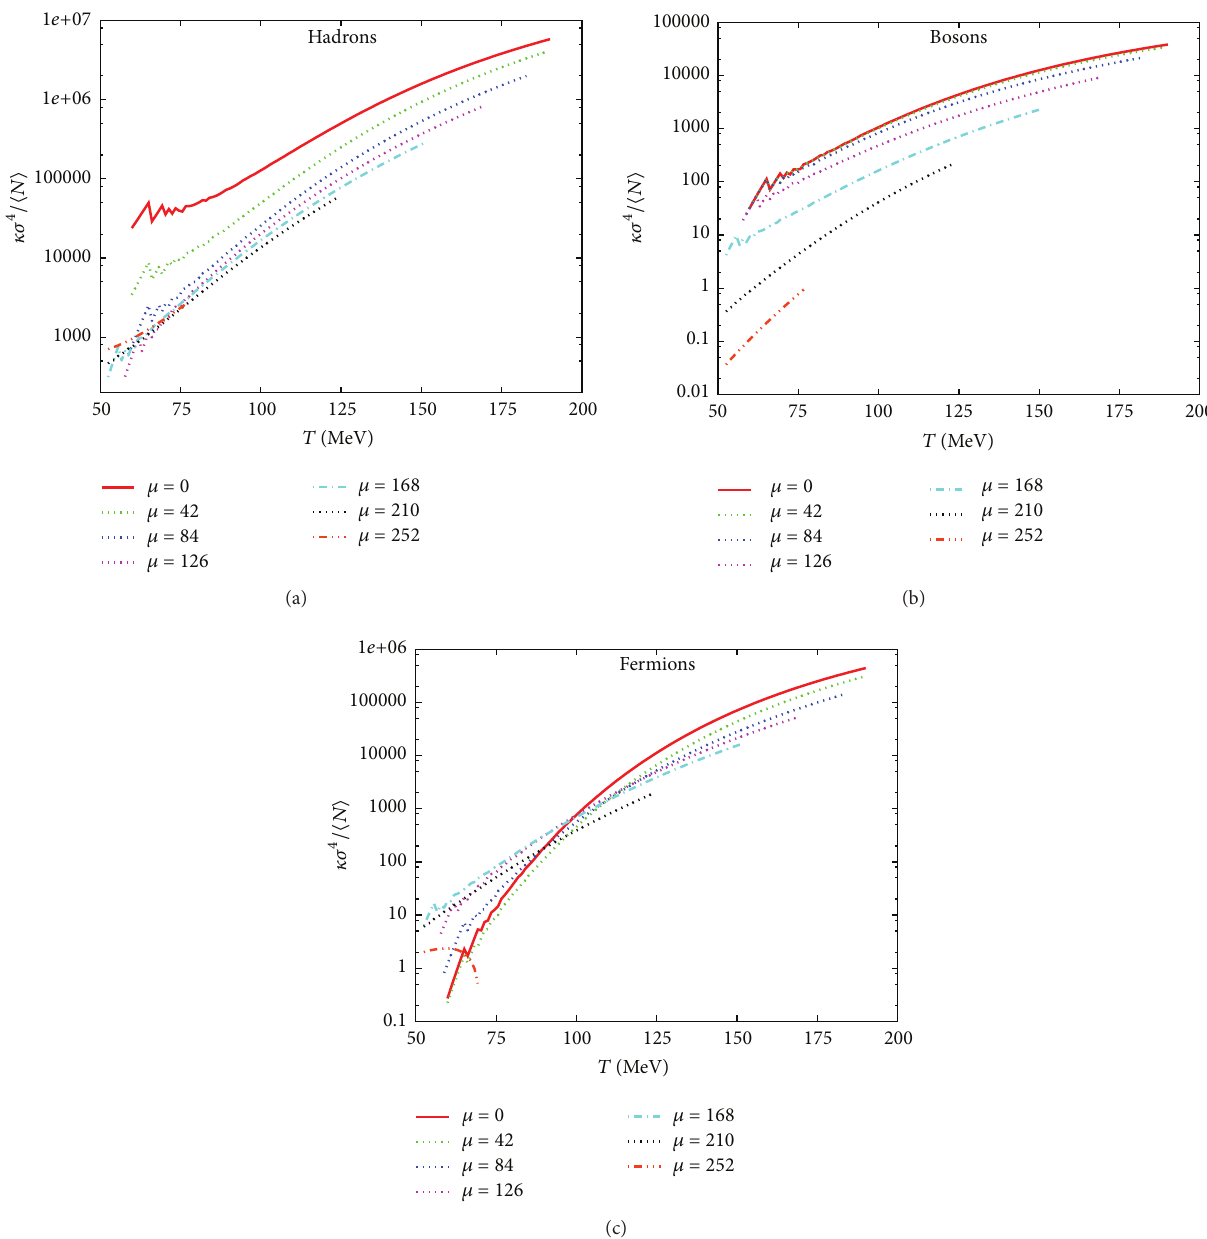
Figure 12: Thermal evolution of 𝜅𝜎 4 /⟨𝑁⟩ for hadrons (a), bosons (b) and fermions (c) at different chemical potentials (given in MeV).